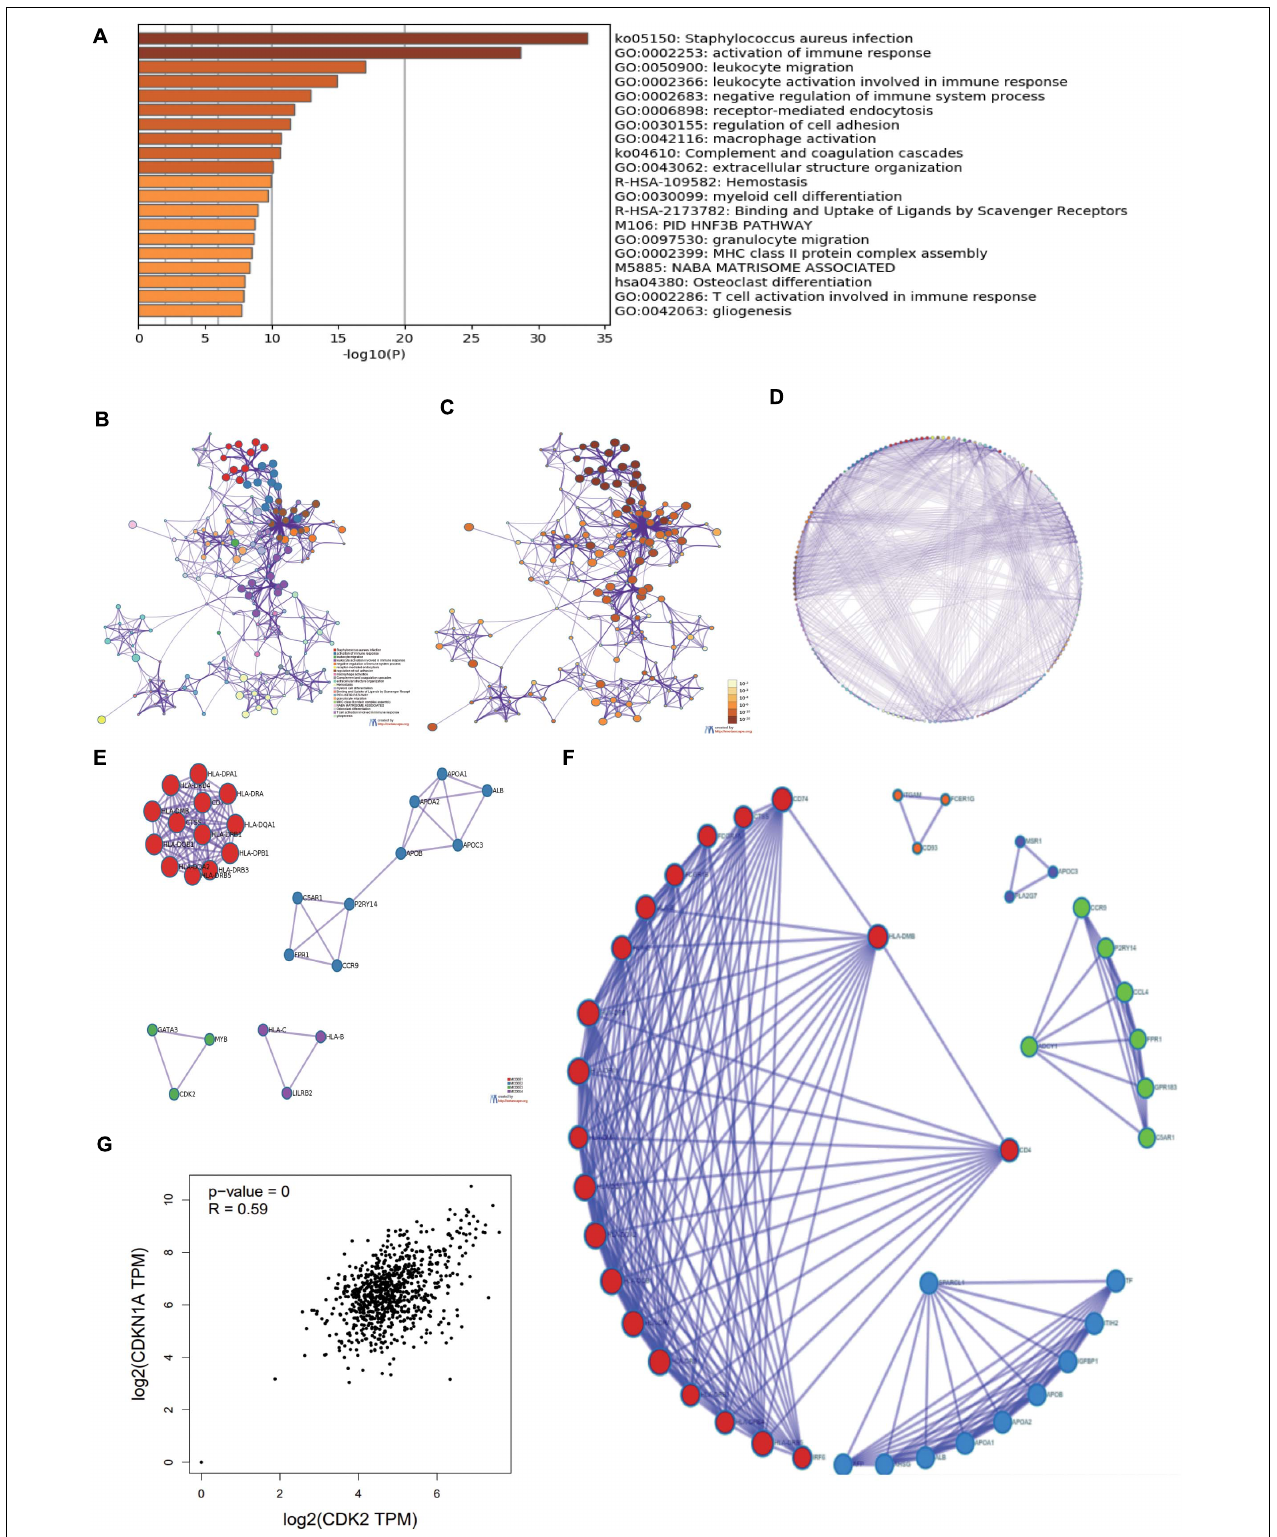
FIGURE 3 | The GO, KEGG analysis of 250 DEmRNAs. (A) Through Metascape software, we found most enriched items. (B) The related paths were shown in the network diagram. (C,D) the P -value of different pathways. (E) According to the relationship of DE mRNAs, several protein analyses were performed. (F) CDK2, MYB, GATA3 were connected each other in some tumor pathway from the circle graph. (G) There was a positive correlation between CDK2 and CDKN1A using GEPIA.